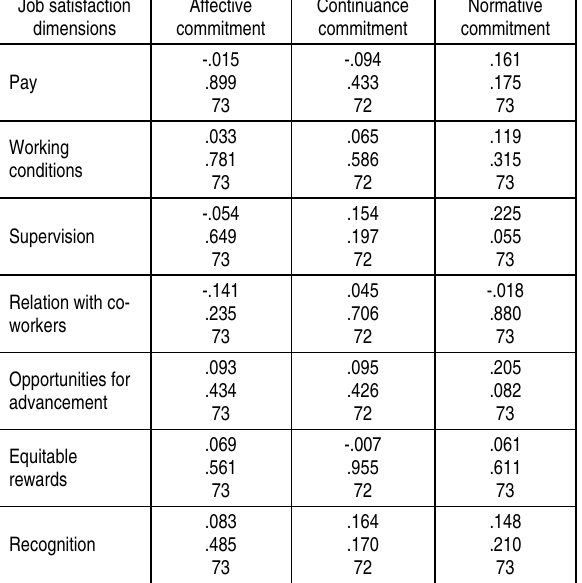
Table 4. Pearson’s correlation matrix between job satisfaction dimensions and organizational